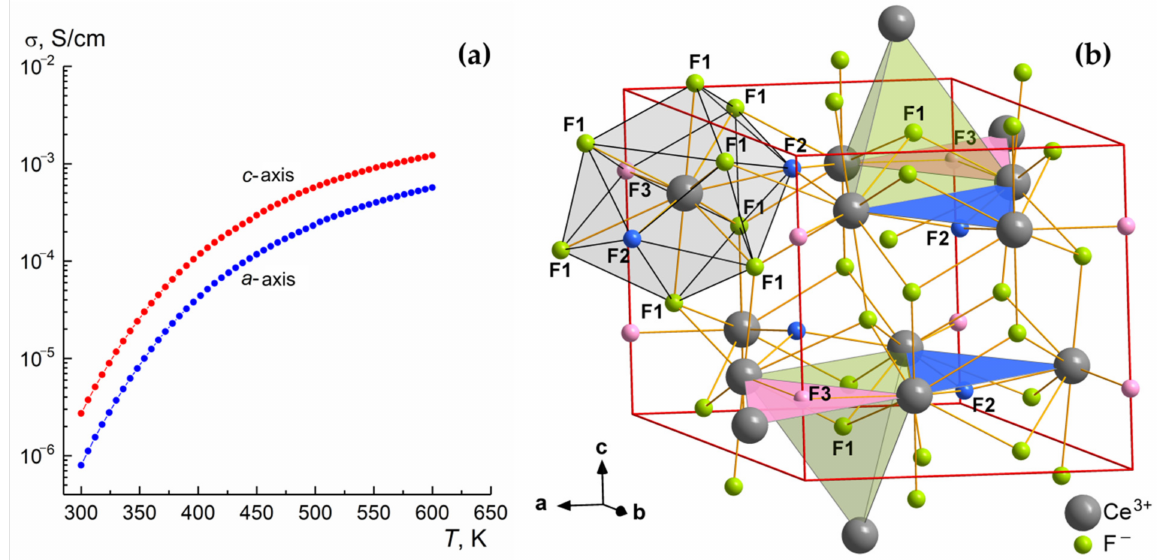
Figure 10. Temperature dependences of the ionic conductivity σ dc along the crystallographic a - and c -axes ( a ) and tysonite unit cell (space group P 3 c 1) of the CeF 3 single crystal ( b ). Polyhedra for the Ce 3+ cations (CeF 11 ) and the different F – sites are